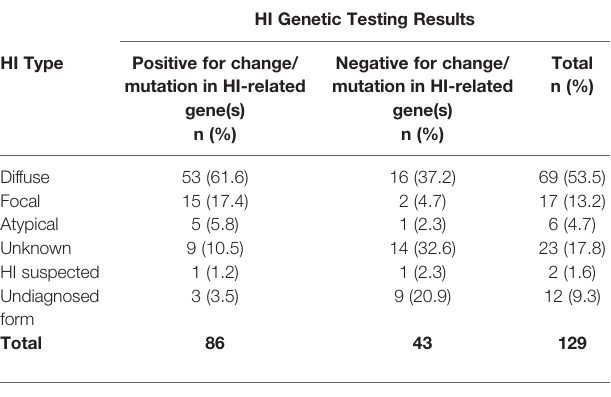
TABLE 2 | Detected HI genes.